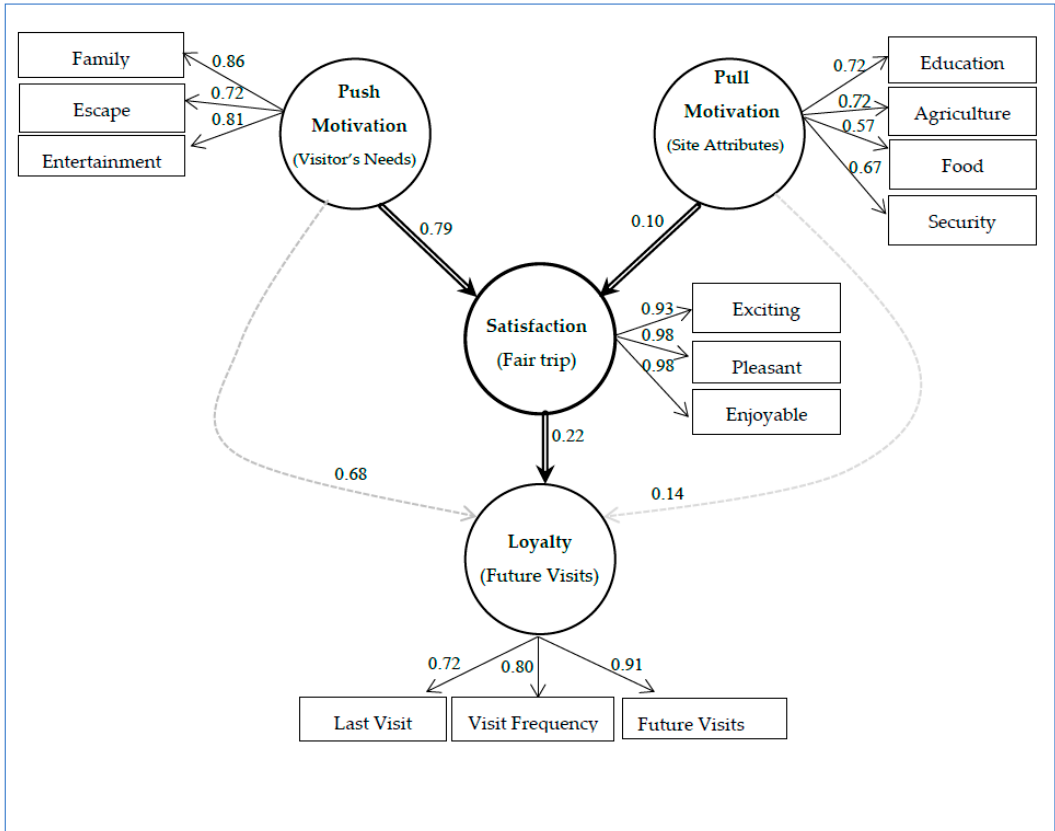
Figure 2. Revised model of visitor motivation for attending agricultural fairs with standardized coefficients. Note: The model goodness of fit indices are as follows: Yuan-Bentler Chi-Square ( χ 2 (df = 54) = 62.14; p = 0.210), RMSEA = 0.024; CI: 0.0–0.039, GFI = 0.996, AGFI = 0.993, CFI = 0.999. All model coefficients are statistically significant at less than five percent level. The numbers shown in the graph are completely standardized coefficients.